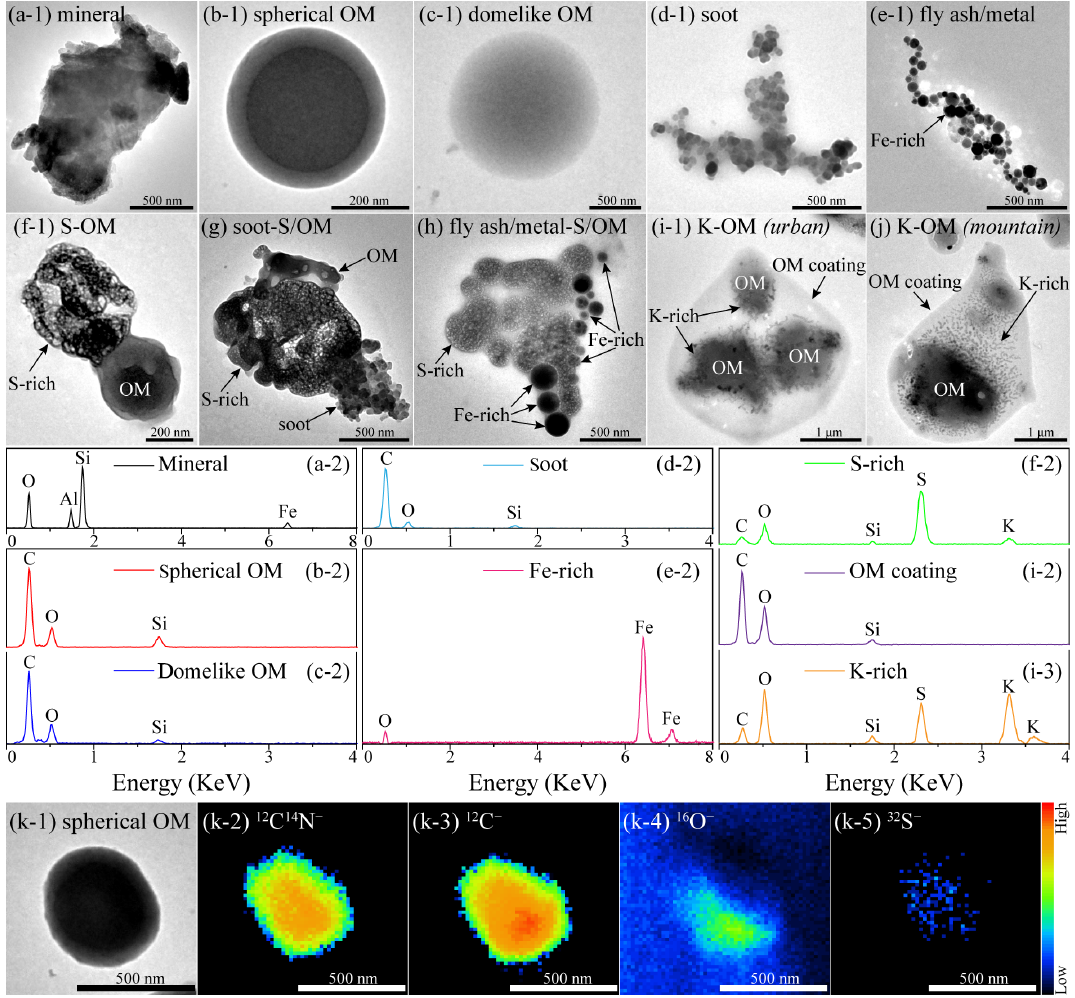
Figure 3. Typical transmission electron microscopy (TEM) images and energy-dispersive X-ray spectrometry (EDS) spectra of different types of individual aerosol particles: (a) mineral particle; (b) spherical OM particle; (c) domelike OM particle; (d) soot particle; (e) Fe-rich particle; (f) mixture of S-rich and OM particles; (g) mixture of soot, S-rich, and OM particles; (h) mixture of Fe-rich and S-rich particles; (i, j) mixture of K-rich and OM particles at the urban and mountain sites. The EDS spectra of these particle components are located below their TEM images. (k) A typically spherical OM particle and its NanoSIMS ion intensity mappings of 12 C 14 N − , 12 C − , 16 O − , and 32 S − signals. Particles in (a–h, k) and (i, j) were collected during the Haze-I and Haze-II events,